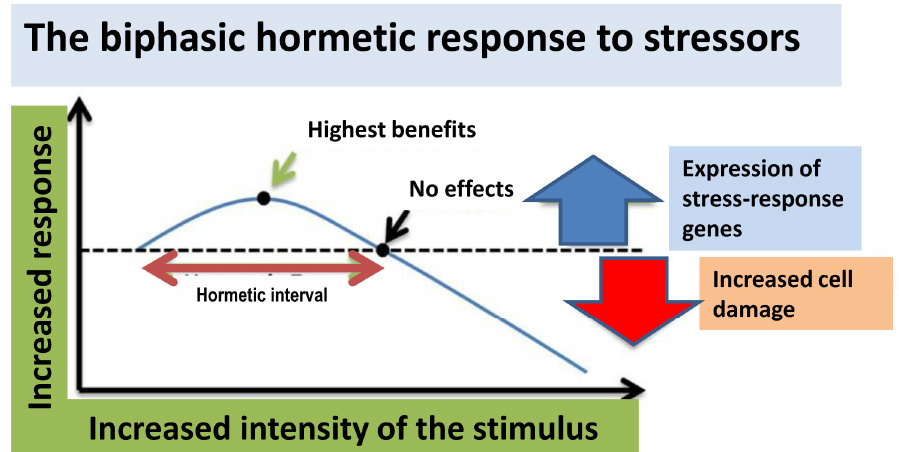
Figure 2. Hormesis describes a biphasic dose-response feature to stressful stimuli.